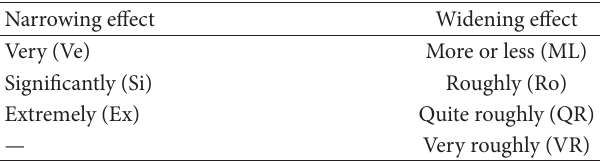
Figure 1: Particular example of real measured values (in black) and the Math-1D model simulation (in gray). Flow rate values [m 3 /s] on the vertical axis are measured on a particular measuring station placed on the Odra River starting from time − 119 up to 0 (horizontal axis, time [ ℎ ]). Starting from the time point “0” to the right, the gray curve denotes the forecast of future flow rate values. Table 1: Linguistic hedges and their